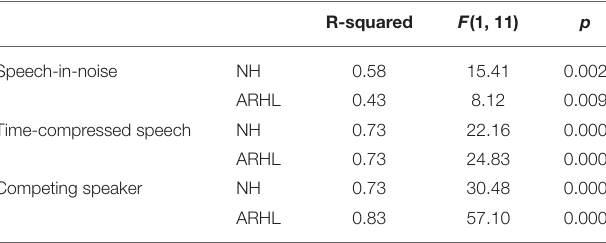
TABLE 2 | Linear curve estimation model of group